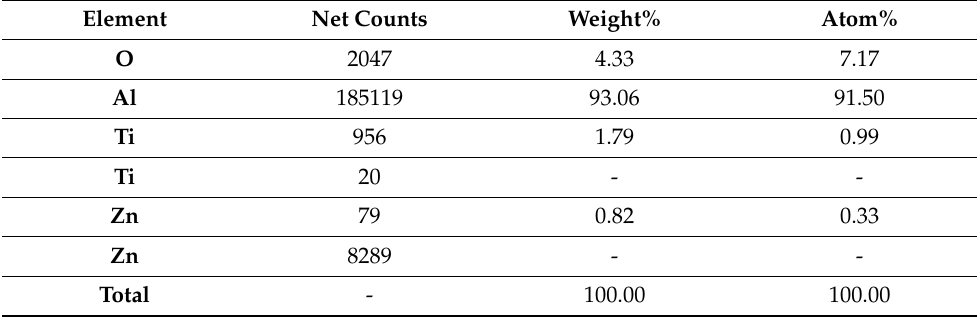
Figure 3. Quantitative electron microprobe analysis of AA7075/6 wt.% TiB 2 in situ composite. Table 1. Elements observed from quantitative electron microprobe (EDAX) analysis of AA7075/6 wt.% TiB 2